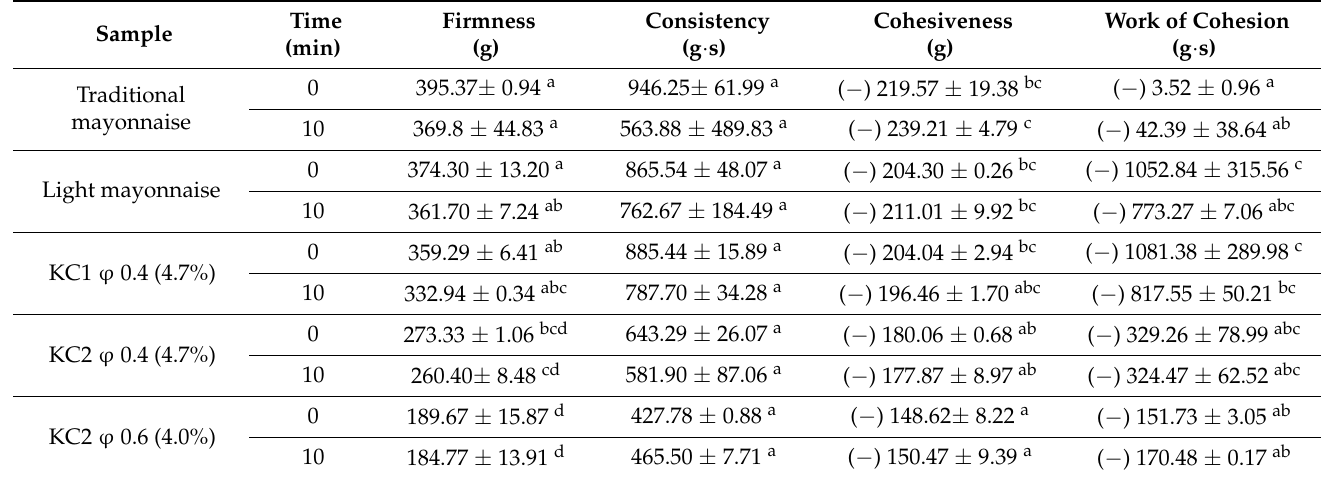
Table 5. Textural properties of the reference food matrices and the Pickering emulsions over